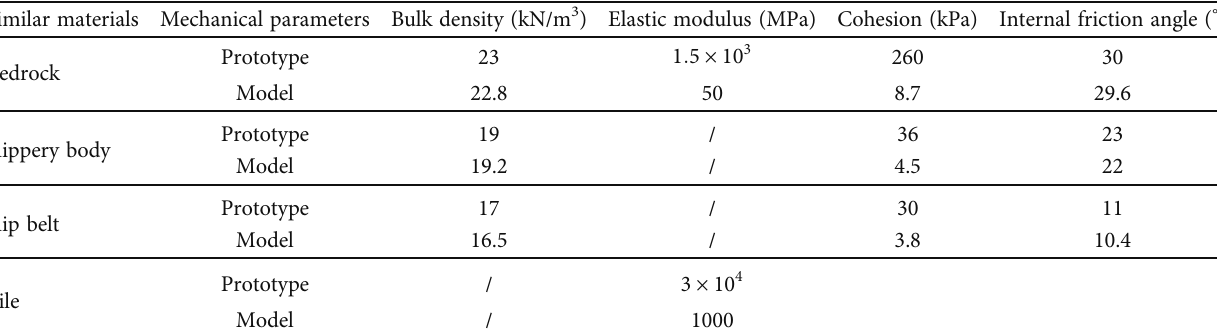
Figure 3: Material preparation for model test. Table 2: Physical and mechanical parameters of similar